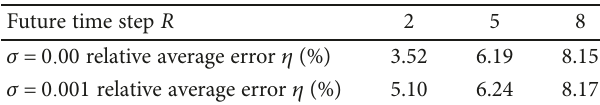
Figure 6: Impacts of di ff erent future time steps on inversion results when σ = 0 00 and L = 0 01m . Table 1: Relative average error of inversion results of di ff erent future time steps when σ = 0 00 and L = 0 01 m .